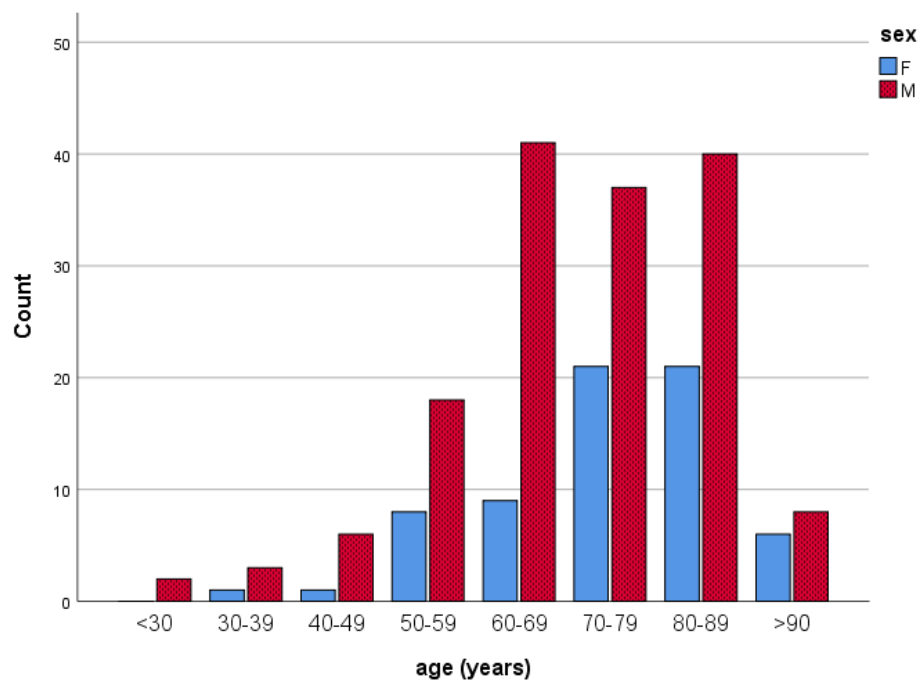
Figure 1. Gender and age distribution of the participants (n = 222).